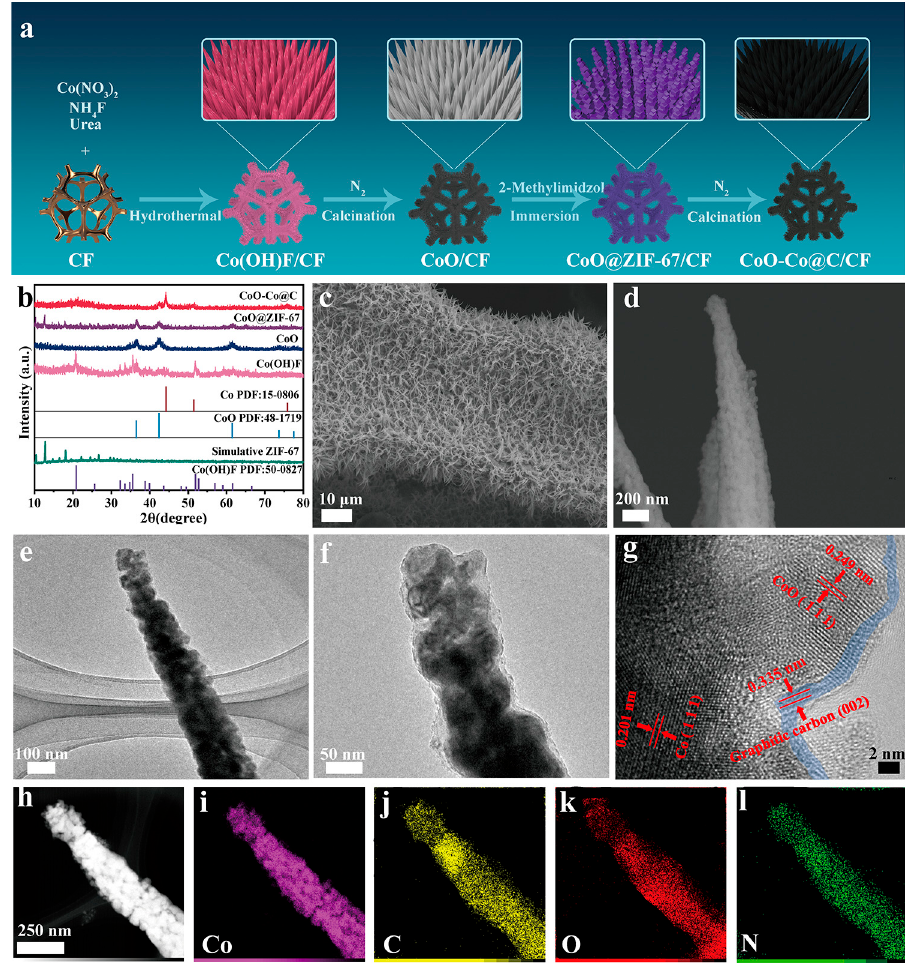
Figure 1. Schematic illustration of the synthetic procedure for CoO–Co@C/CF ( a ), XRD patterns of Co(OH)F, CoO, CoO@ZIF-67, and CoO–Co@C exfoliated from CF ( b ); SEM images ( c , d ), TEM images ( e , f ) and high-resolution TEM image ( g ), TEM-EDS element mapping images ( h – l ) of CoO–Co@C exfoliated from